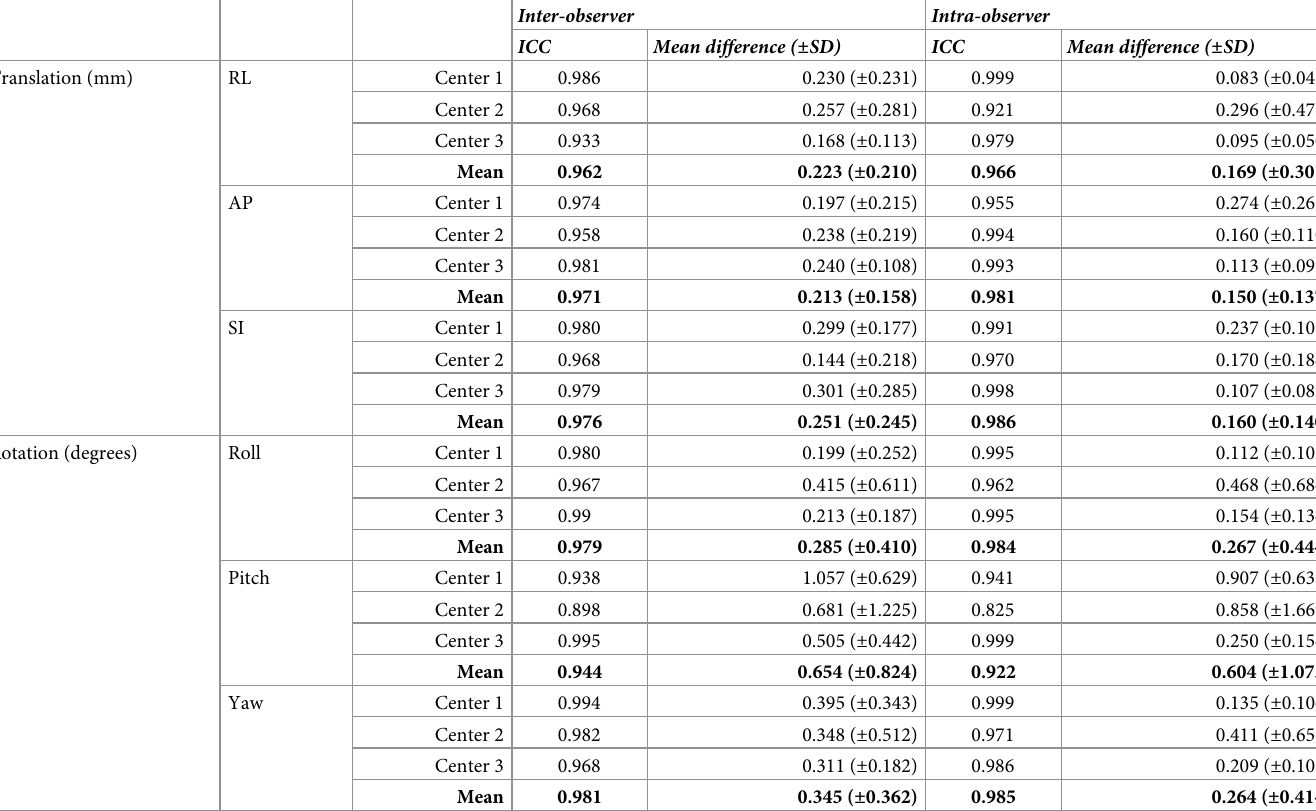
Table 5. Intra-observer and inter-observer differences and intraclass correlation coefficients (ICC) for measurements of the chin. Inter-observer